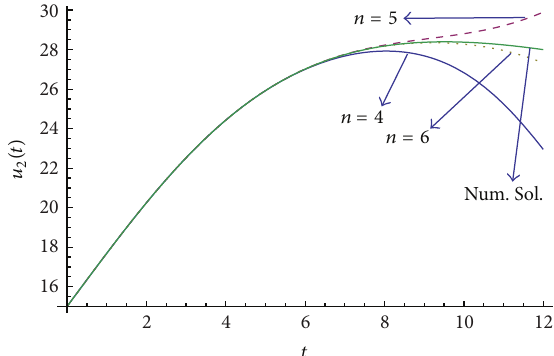
Figure 1: Comparison of iterations ( 𝑛 = 4, 5, 6 ) of PIA(1, 1) and numerical solutions for 𝑢 1 .